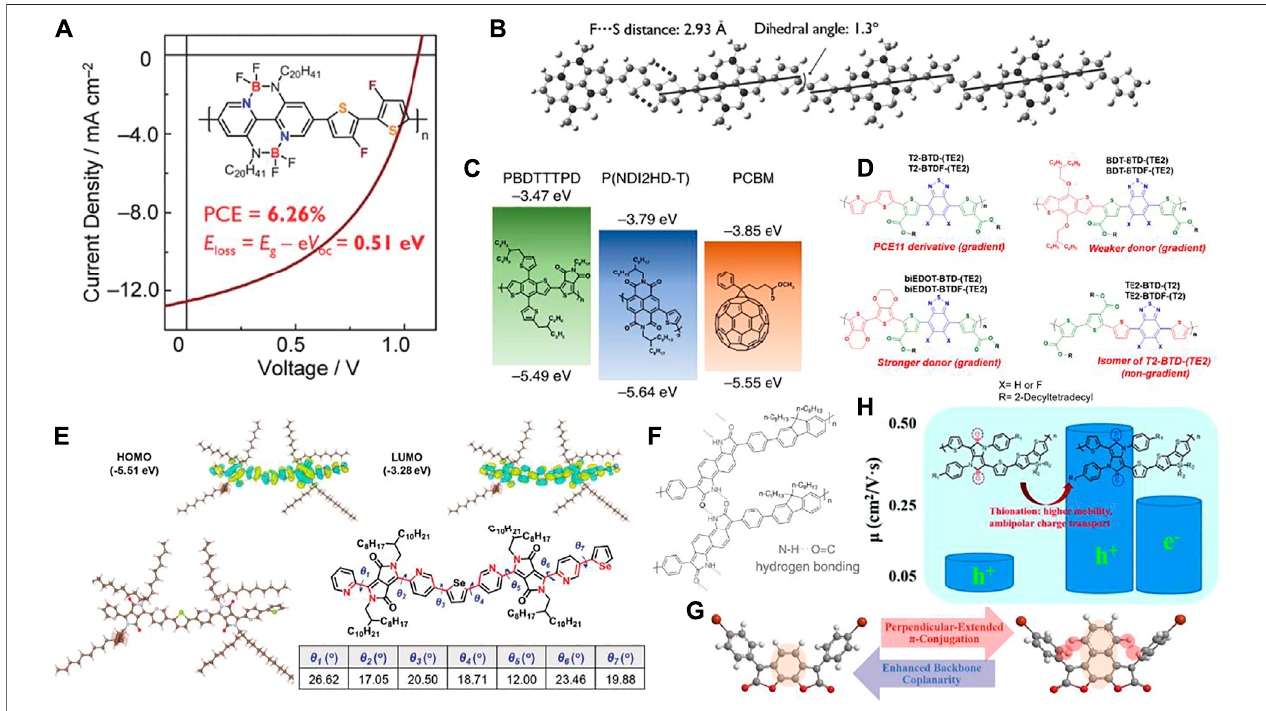
FIGURE1|(A) ChemicalstructureofthepolymeraswellastheJ – VcurvesofOSCdevice (B) Optimisedcon fi gurationofthemodelcompoundofP-BNBP-fBT, (C) Chemical structures and energy levels of PBDTTTPD, PCBM, and P(NDI2HD-T), (D) Chemical structures of the eight polymers, (E) DFT calculations for polymer dimer with full side chains, (F) Hydrogen-bonded naphthodipyrrolidione-based polymer, (G) Chemical structures of 1,8-benzodifuranone and 1,10-naphthodifuranone, (H) Chemical structures of the two polymers as well as their charge transfer mobility.